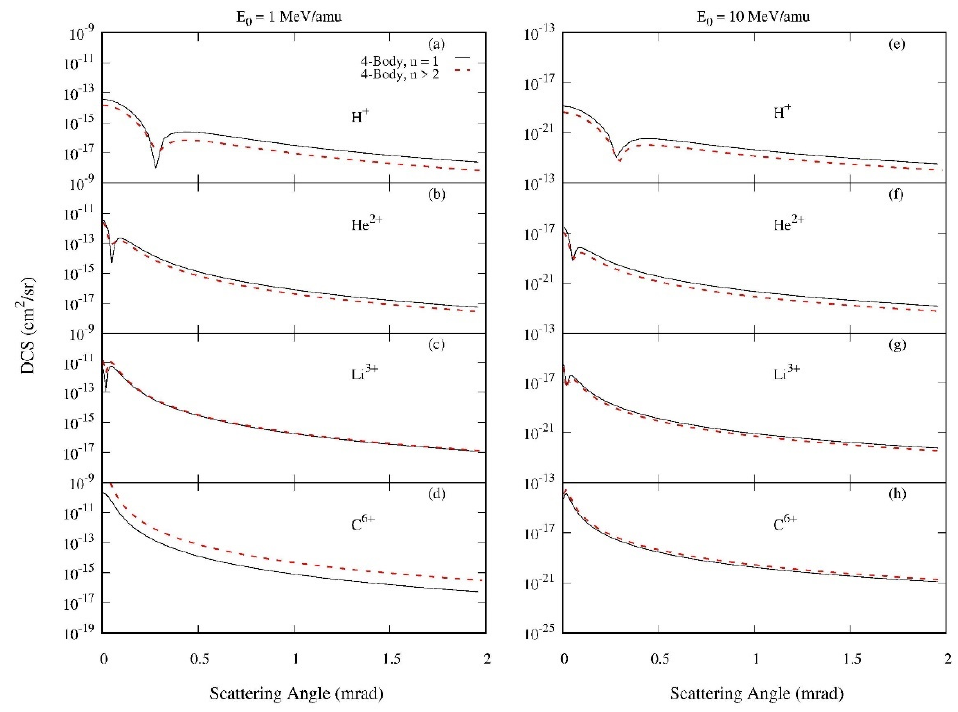
Figure 7. Di ff erential cross sections using the four-body model (uncorrelated) for capture to the ground state and capture to all excited states up to and including n = 6 .